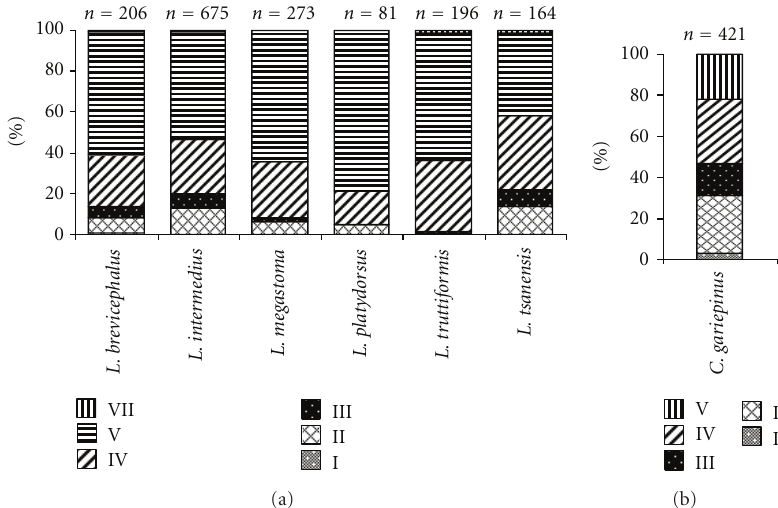
Figure 5: Gonad stages of immature (gonad stages I–III), ripe (gonad stages IV and V) and spent (gonad stage VII) of the six most abundant Labeobarbus species aggregating at Ribb River mouth (a), and C. gariepinus collected from Shesher and Welala wetlands (b). Note that gonad maturity stage V is ripe for Labeobarbus spp., but spent for C. gariepinus .